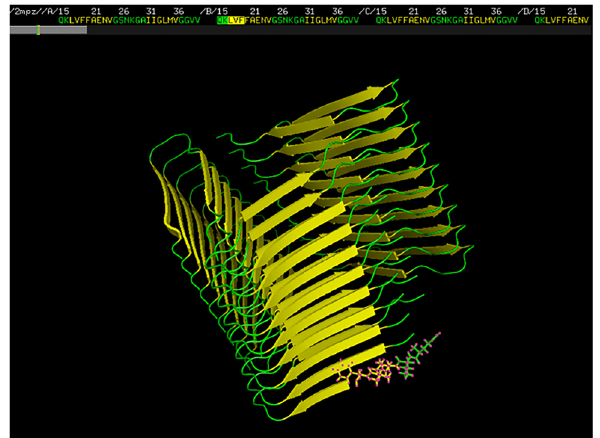
Figure 1: PDB entry 2MPZ, depicted with PyMol. Yellow color denotes 𝛽 -sheets. The QKLVF prefix, where QK is green (it is not a part of the parallel 𝛽 -sheet) and LVF is yellow (i.e., LVF are the first three residues of the parallel 𝛽 -segment), is emphasized at the right bottom of the figure, while its corresponding sequence at the top